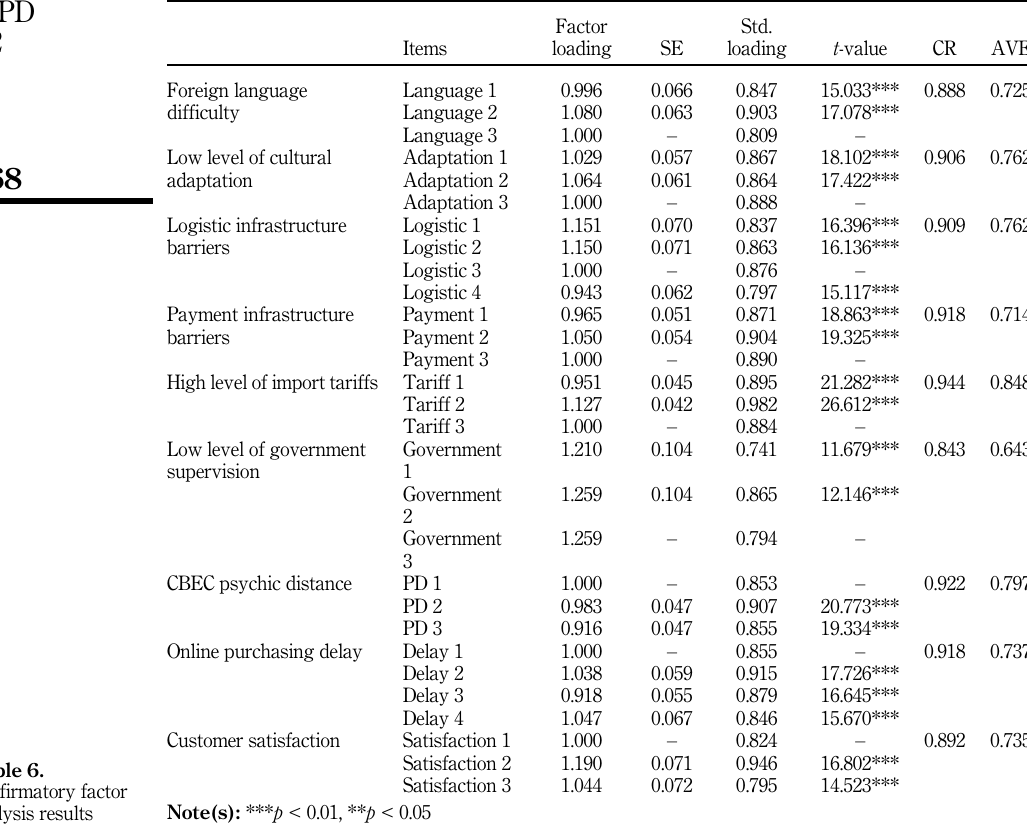
Table 6. Confirmatory factor analysis